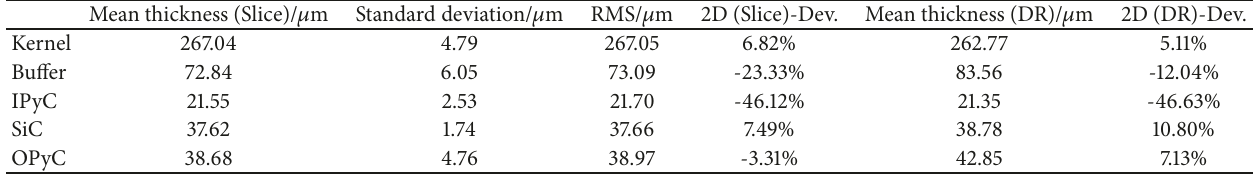
Figure 3: Diameter/thickness distribution of (a) kernel, (b) buffer, (c) IPyC, (d) SiC, and (e) OPyC with 3D measurement. Table 3: 2D measurement of thickness for